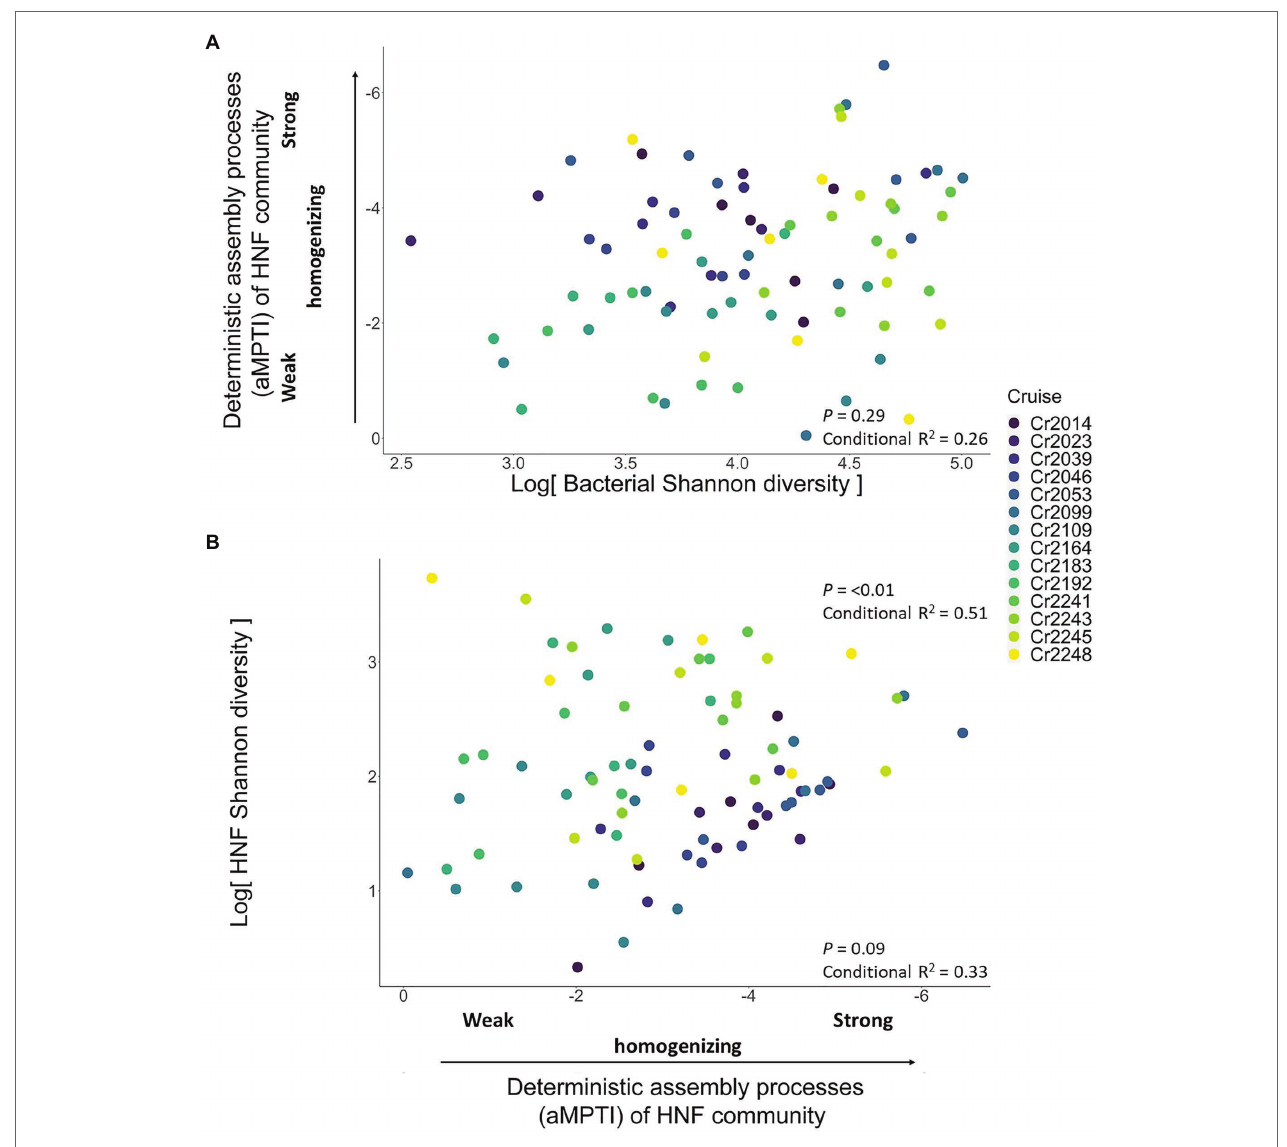
FIGURE 4 | Scatterplots showing the test for bottom-up controlled mechanisms. Panel (A) shows the non-significant relationship (dashed blue line) between bacteria Shannon diversity and the deterministic assembly processes ( α MPTI ) of HNF community. Panel (B) shows the non-significant relationship (dashed blue line) between the α MPTI of HNF community and the Shannon diversity of HNF. The p -value and R 2 are derived from univariate GLMM, whereas including other environmental variables does not qualitatively alter the conclusions ( Table 1 ). Note that the α MPTI of bacteria are mostly negative, so that, we reversed the y axis of panel (A) and x axis in panel (B) for visual intuition. The gray shaded area around the blue line indicates the 95% confidence interval of the regression line (GLMM). The colors of dots represent different sampling